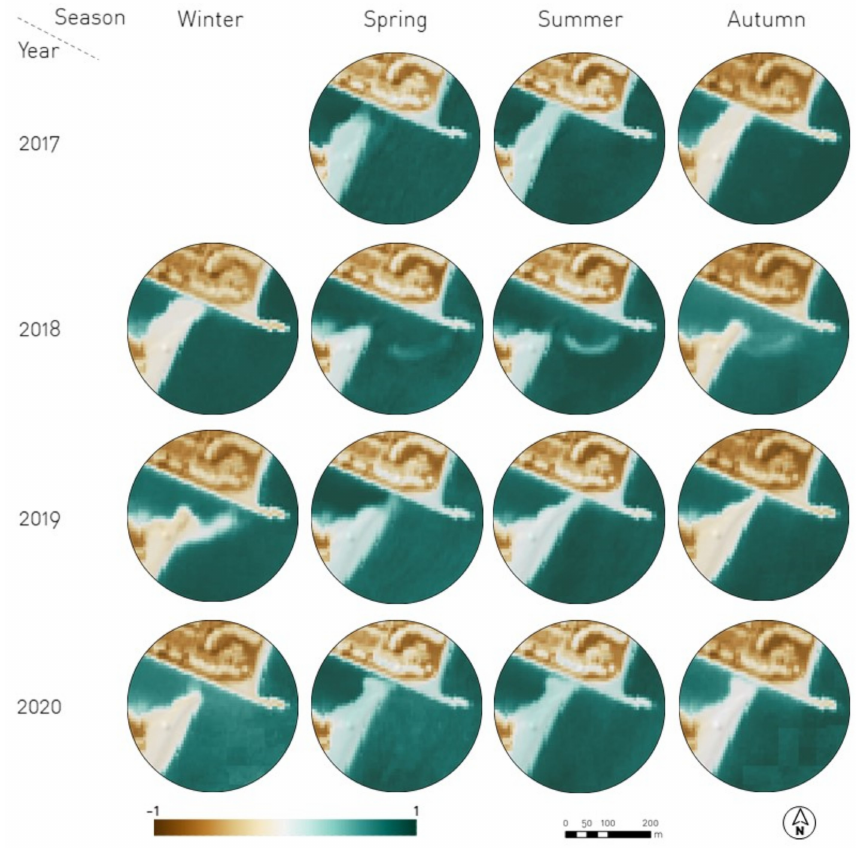
Figure 8. Seasonal climatologies using Sentinel-2 L2A images and NDWI index for the Guadiaro river mouth and its dynamic sand bar between spring 2017 and autumn 2020. Scale